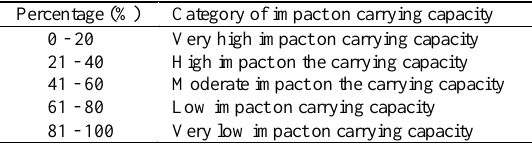
Table 1: The standard for impact category of carrying capacity Percentage (%) Category of impact on carrying capacity 0 -